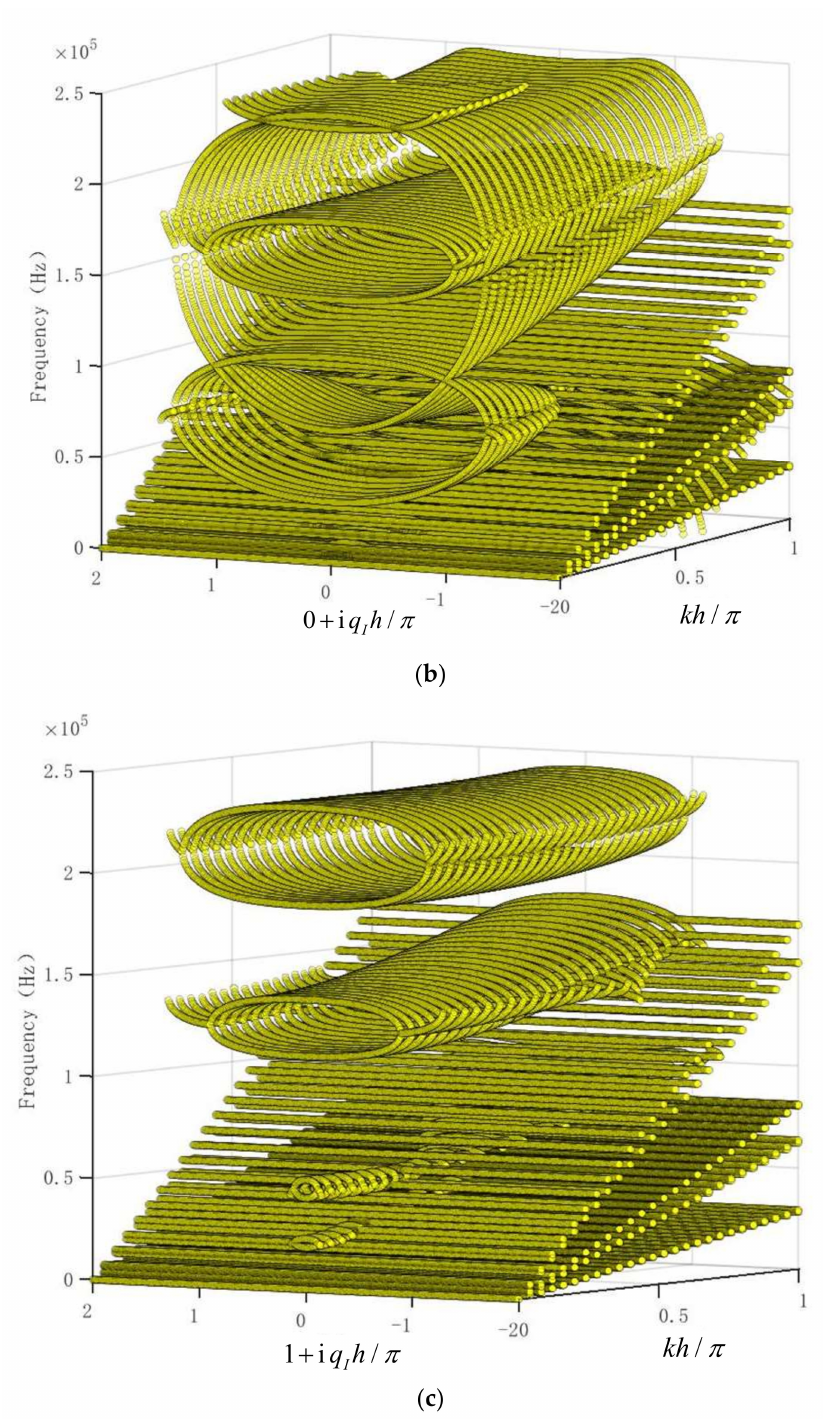
Figure 9. The dispersion surfaces of the Floquet in–plane waves in the exemplified periodically octal– layered isotropic media: ( a ) qh / π = q R h / π , ( b ) qh / π = 0 + i q I h / π , and ( c ) qh / π = 1 + i q I h / π